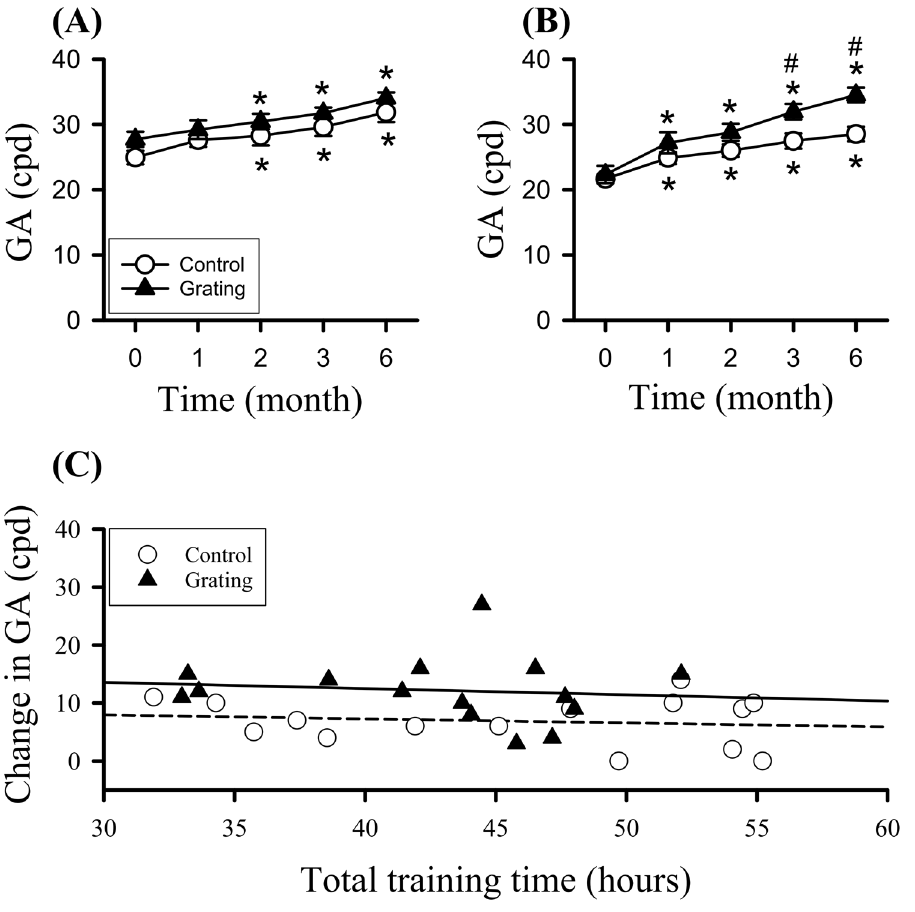
Figure 3. Grating acuity (GA) at the baseline (0), 1st, 2nd, 3rd, and 6th months after the training. ( A ) GAs in patched eyes of the control and Grating groups. ( B ) GAs in trained eyes of the control and Grating groups. *p < 0.05 versus baseline, # p < 0.05 versus the control group. ( C ) Relationship between GA gain from the 6th month to baseline and total training time in trained eye of the two groups. The long dashed (control) and solid (Grating) lines represent the linear regression line fit the